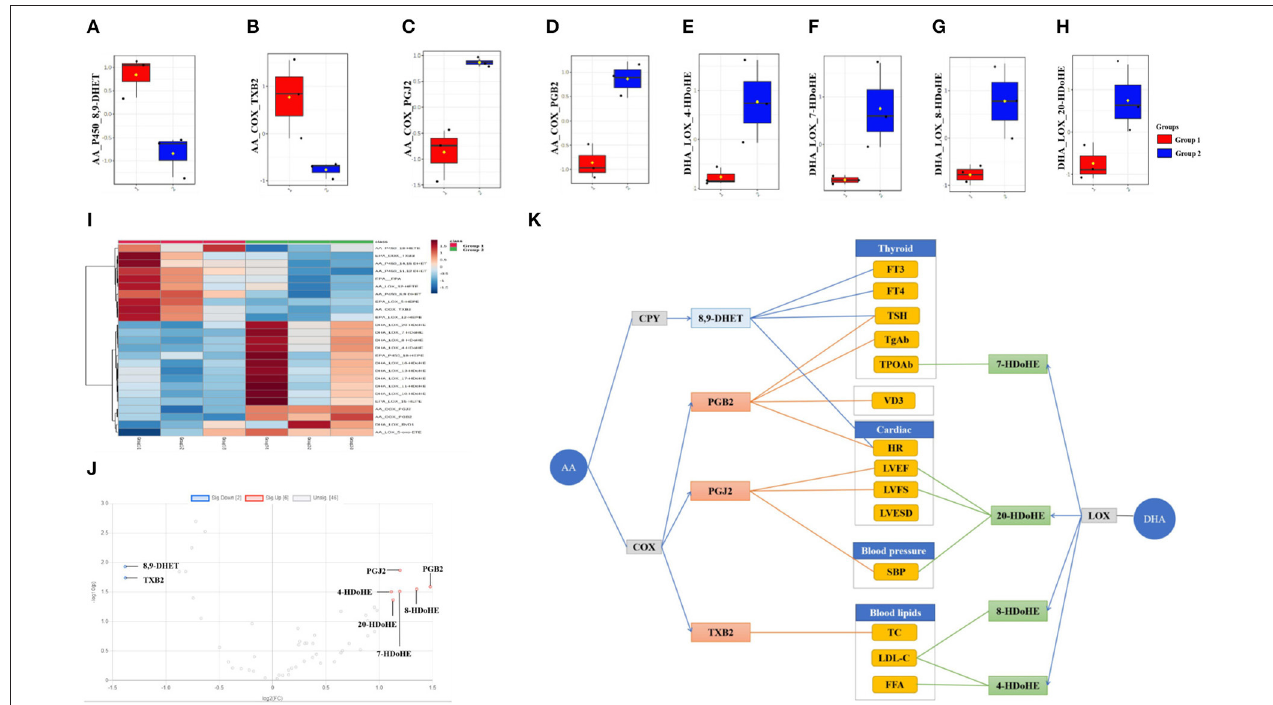
FIGURE 3 | Fatty acids profile and correlation analysis in the continued 100 HI administration group (group 2). (A–H) Box plots of the fatty acids levels. The bar in the quartile-indicating box is the median value. (I) Heat map shows the fatty acids profile from group 1 and group 2. (J) Volcano plot shows the significance and fold change in expression of fatty acids. (K) Correlation analysis between significantly changed fatty acids and thyroid function, cardiac function, blood lipids, and vitamin D3 (VD3) levels in the continued 100 HI administration group (group 2). n = 6 for each group.